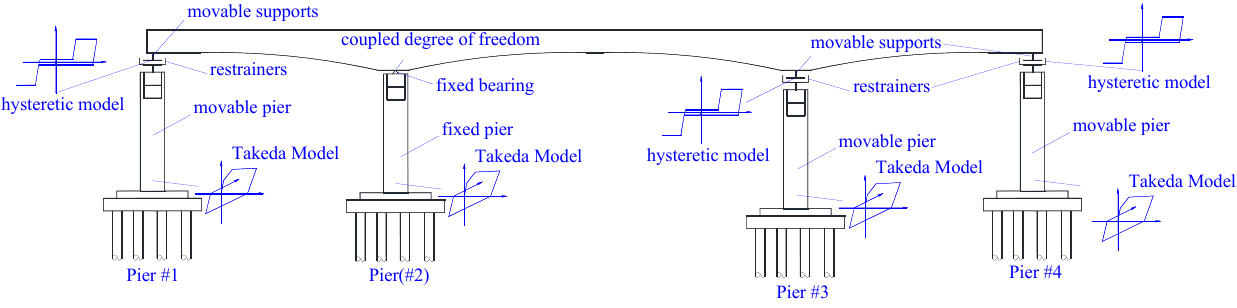
Figure 6: Calculation Diagram for Model